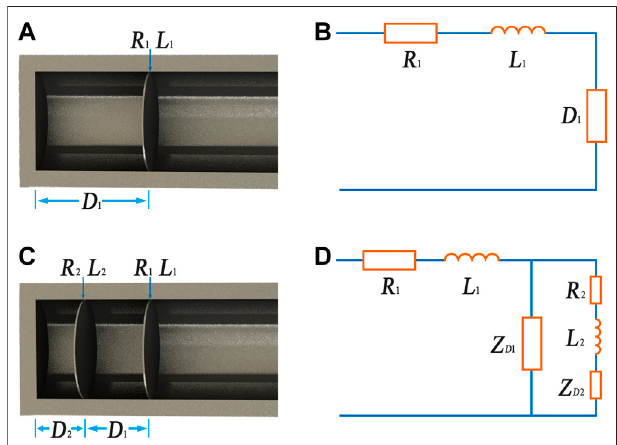
FIGURE 6 | Schematic diagram (A) and equivalent circuit (B) of the single-layer membrane structure, schematic diagram (C) and equivalent circuit (D) of the double-layer membrane